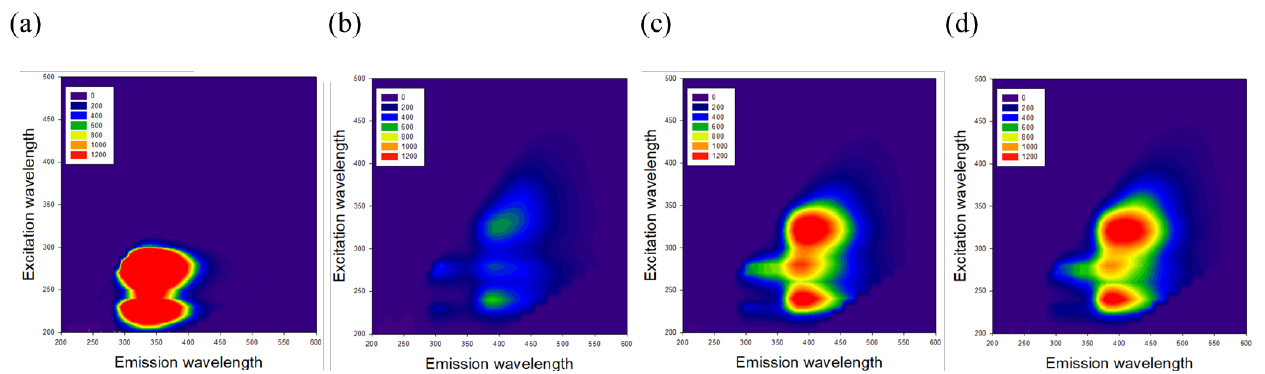
Figure 3. Effect of GKM3 and GKK2 on the 3-D fluorescent intensity of products in the final stage of protein glycation: ( a ) native BSA; ( b ) MG-BSA; ( c ) MG-BSA with GKM3; ( d ) MG-BSA with GKK2. Results shown are excitation – emission matrices (EEMs) of each group (excitation range: 200 – 500 nm; emission range: 200 – 600 nm).